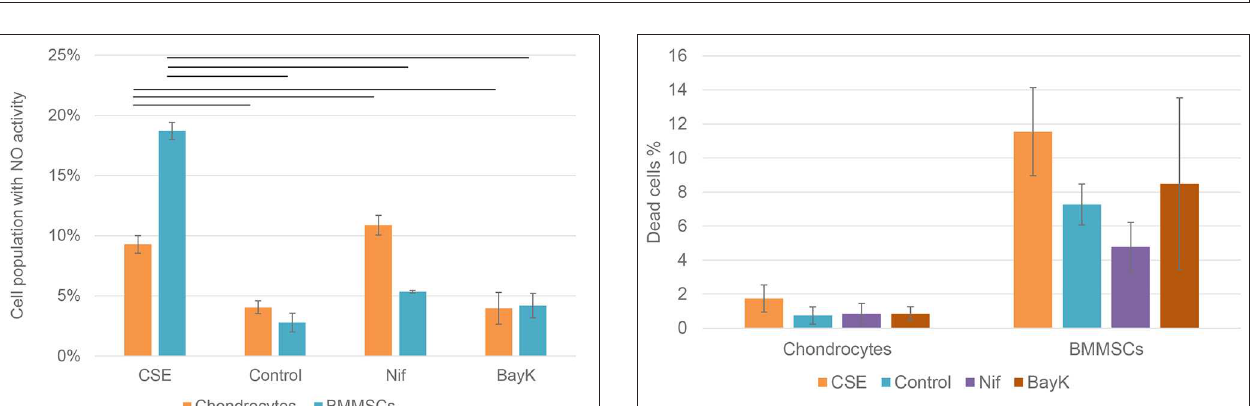
FIGURE 8 | Mean fluorescence intensity (MFI) of intracellular calcium Ca 2 + dye Cal-520 in chondrocytes and BMMSCs after treatment with nifedipine (10 µ M) (Nif), BayK8644 (10 µ M) (BayK), IL-1 β (1ng/mL) (IL-1b), IL-1 β (1ng/mL) + BayK8644 (10 µ M) (BayK), and IL-1 β (1ng/mL) + nifedipine (10 µ M) (Nif) for 24h. Horizontal bars represent p < 0.05.